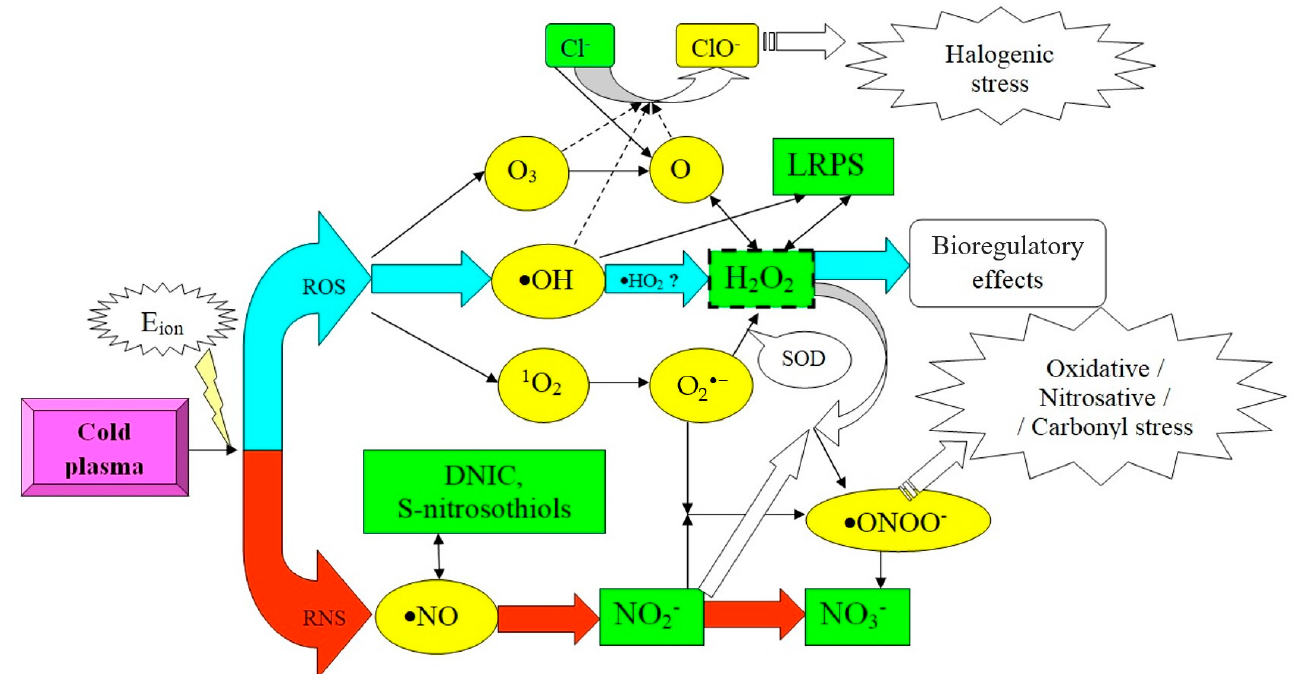
Figure 1. Molecular cascades, induced by the action of cold atmospheric plasma (ROS—reactive oxygen species, RNS—reactive nitrogen species, LRPS—long-living reactive protein species, DNIC—dinitrosyl iron complexes, Eion—ionization energy, SOD—superoxide dismutase).